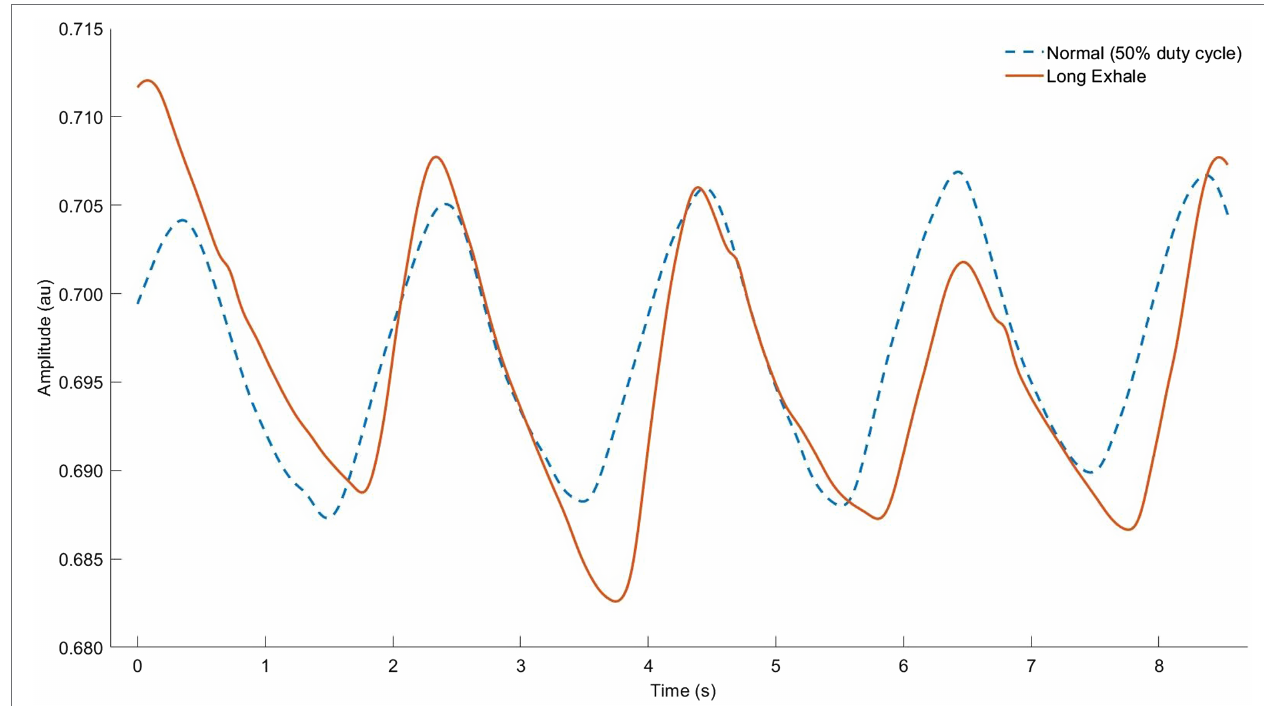
FIGURE 6 | Respiratory inductance plethysmography (RIP) data from our lab showing normal breathing (dashed line) vs. “active exhale” breathing strategy (solid line). Note that raw RIP data depict inductance, where signal increases (upward slope) correspond to the exhale phase. Observe the identical breath cycle time, but shorter relative inhale and longer exhale (smaller breath ratio) as well as lower average lung operating volume throughout the breath cycle (higher signal units indicating decreased sensor